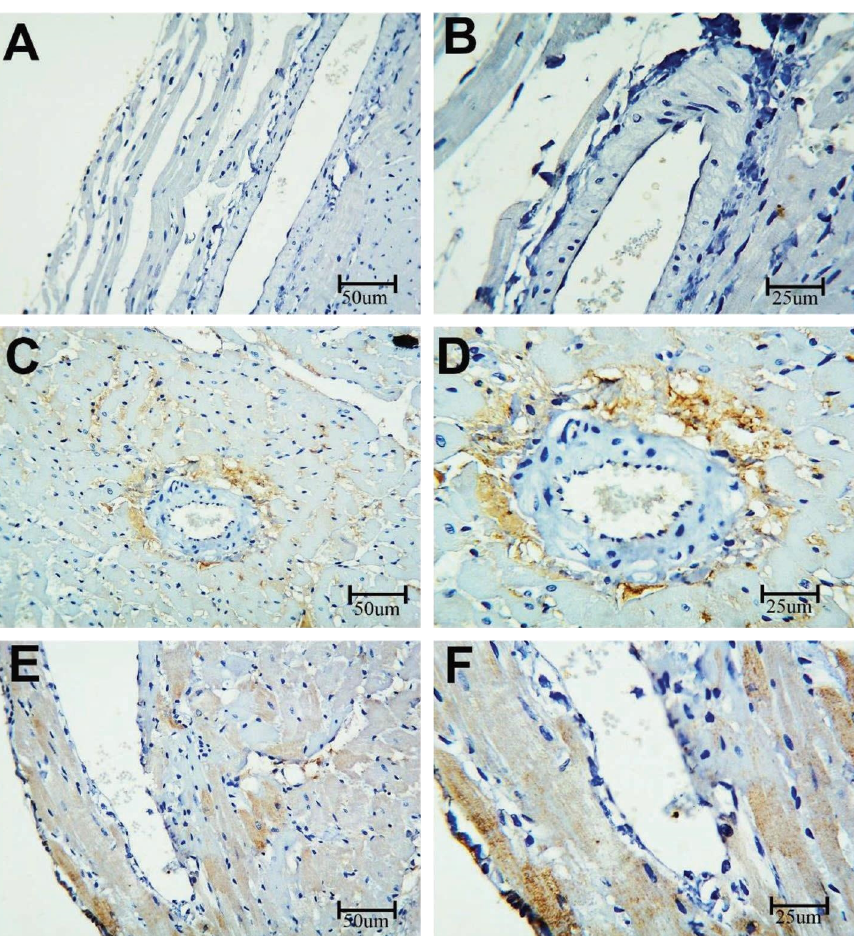
Figure 6: Histopathological section of the coronary artery of the rat stained with the caspase-3 immune stain. a and b are the control group, c and d are the BPA group, and e and f are the BPA +LC group. Te coronary artery of the control group shows a minimal expression of the dye in the wall of the artery. Te expression of the color is notably increased in the BPA group and reduced in the PBA +LC group (caspase-3 immune stain; A, C, and E X 200; B, D, and F X